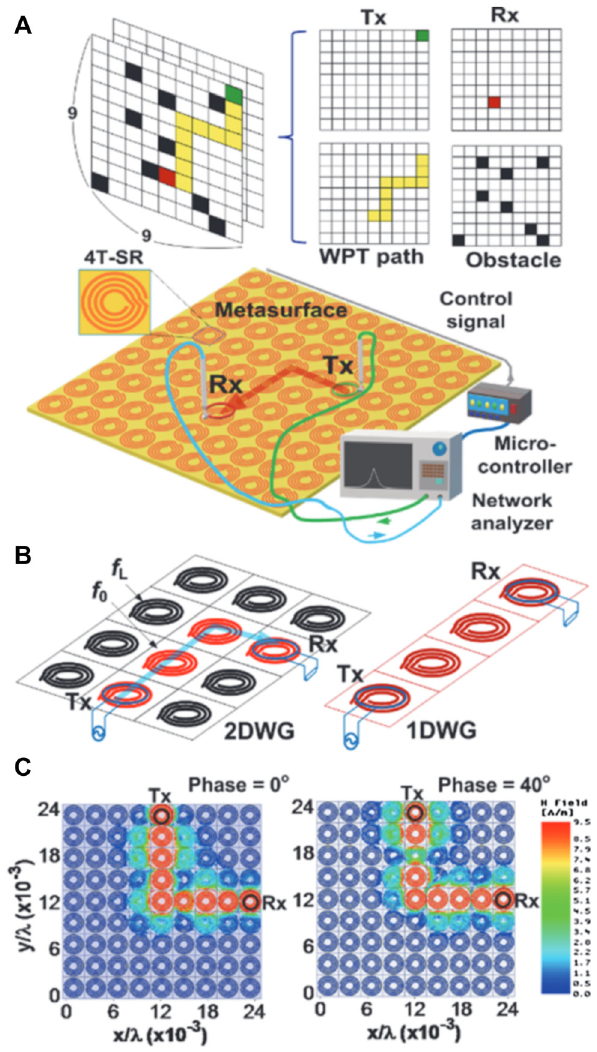
Figure 12: Tunable metamaterials for coupling WPT. (A) Tunable metamaterial for the power transmission. (B) Energy transmission path. (C) Distribution of the EM energy [95]. Reprinted from [95], with the permission of IEEE